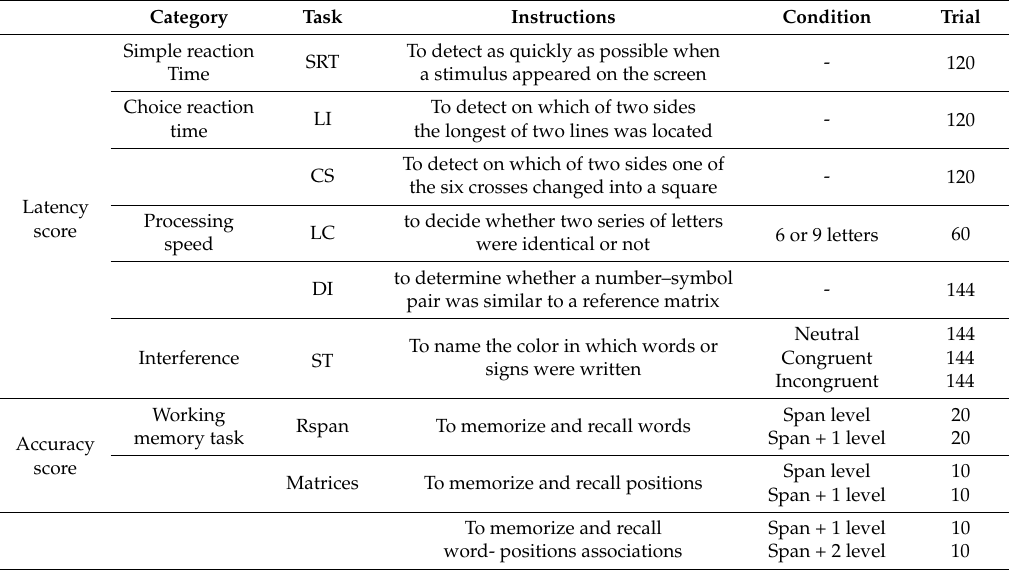
Table 2. Descriptions and characteristics of tasks used in this